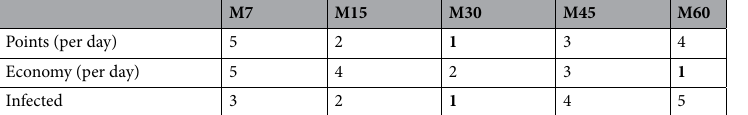
Table 2. The table accumulates the overall comparisons of the memory-based agents. For each comparison, we initialize rankings for each agent. Lower orders are better. Agent M30 comparatively performs better than the rest of the agents. Minimum orders are marked as bold.